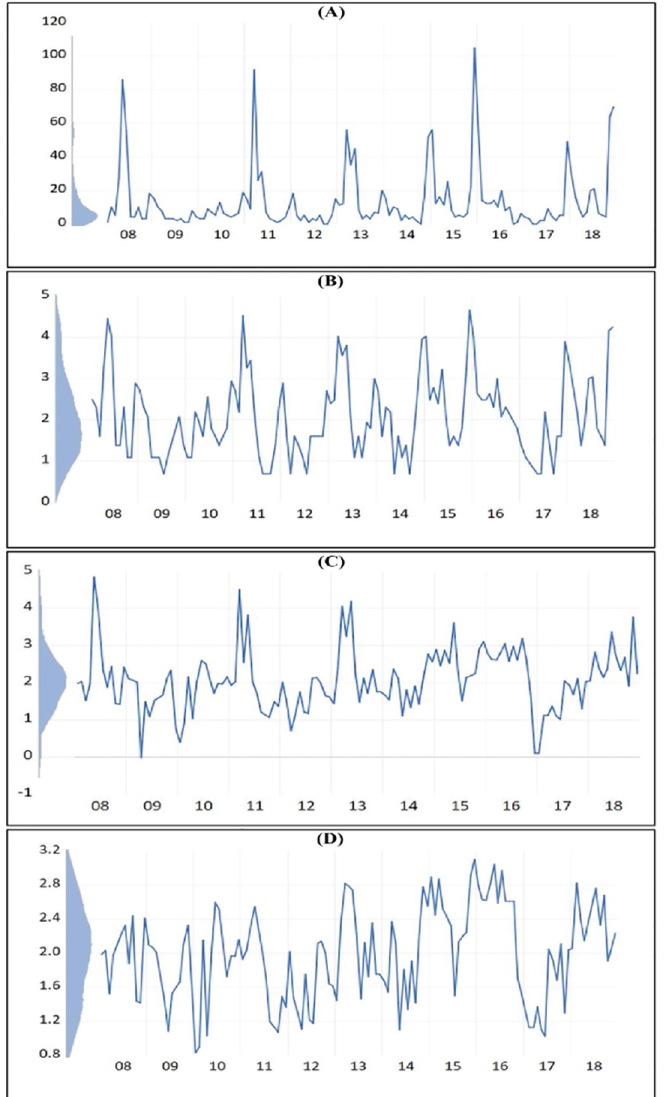
Fig 3. A-D: Distribution of monthly leptospirosis cases from January 2008 to December 2018 in Anuradhapura District, Sri Lanka, with kernel density. (A-Original distribution; B-Natural-log transformed; C-natural-log transformed and seasonally adjusted; D-natural-log transformed, seasonally adjusted and seasonal outliers adjusted).